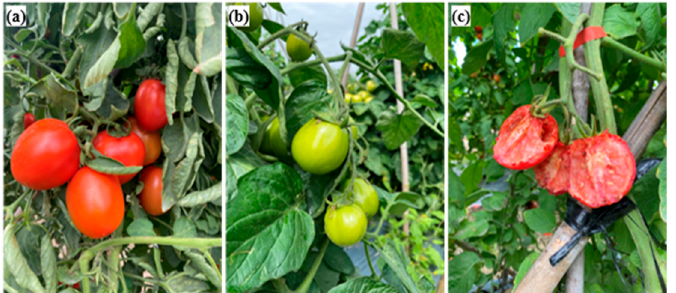
Figure 5. Illustrative images of tomatoes in three states: ( a ) ripe, ( b ) immature, and ( c ) damaged.